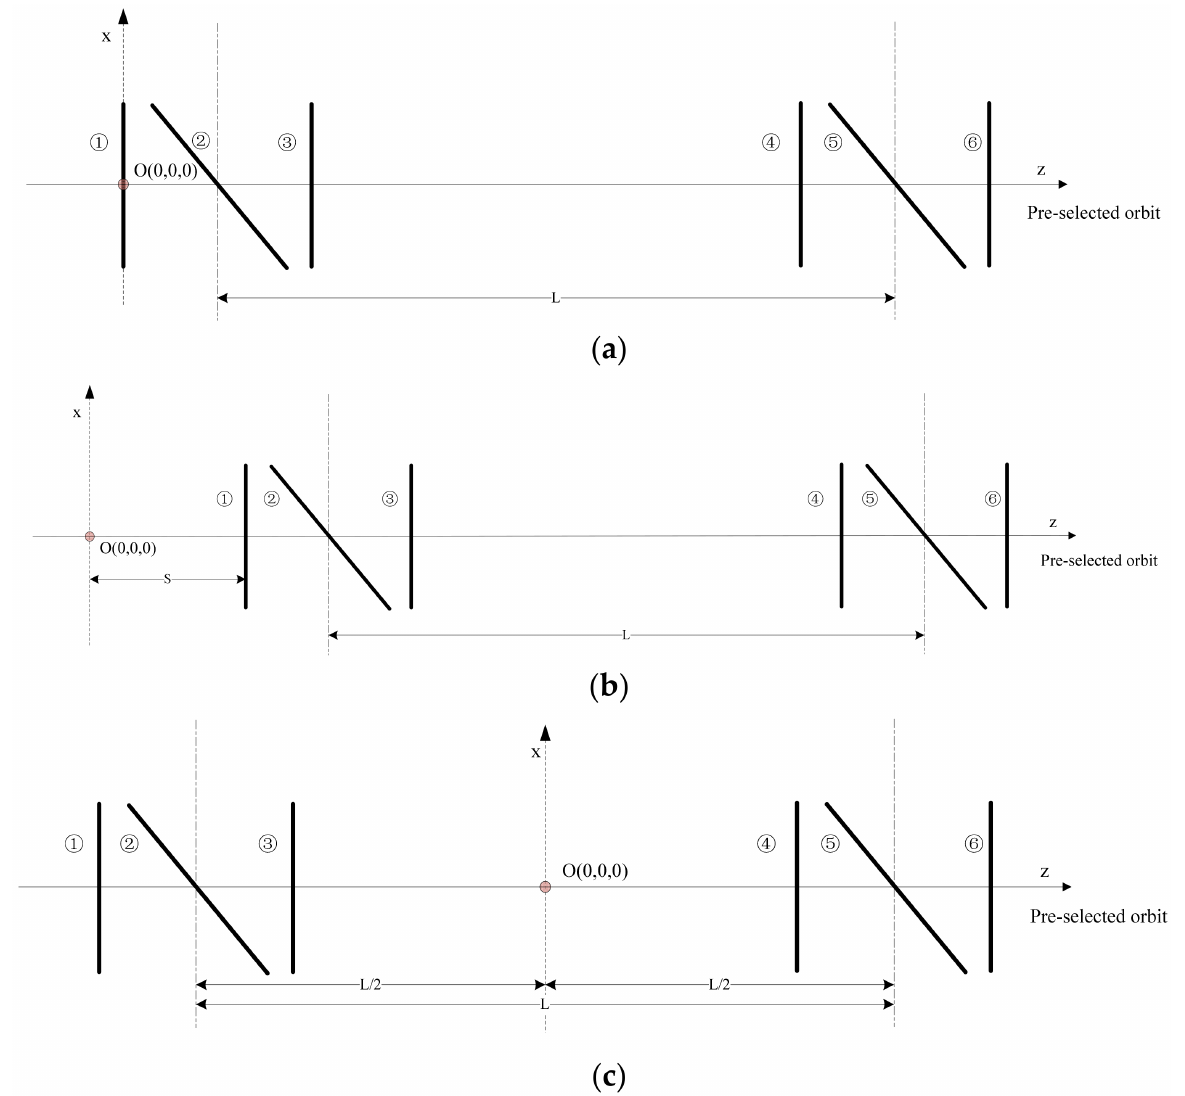
Figure 2. Coordinate-comparison diagrams of different pulse-time origins. ( a ) The origin is on the first screen; ( b ) The origin is at the S position in front of the first screen; ( c ) The origin is in the center of the two light screen